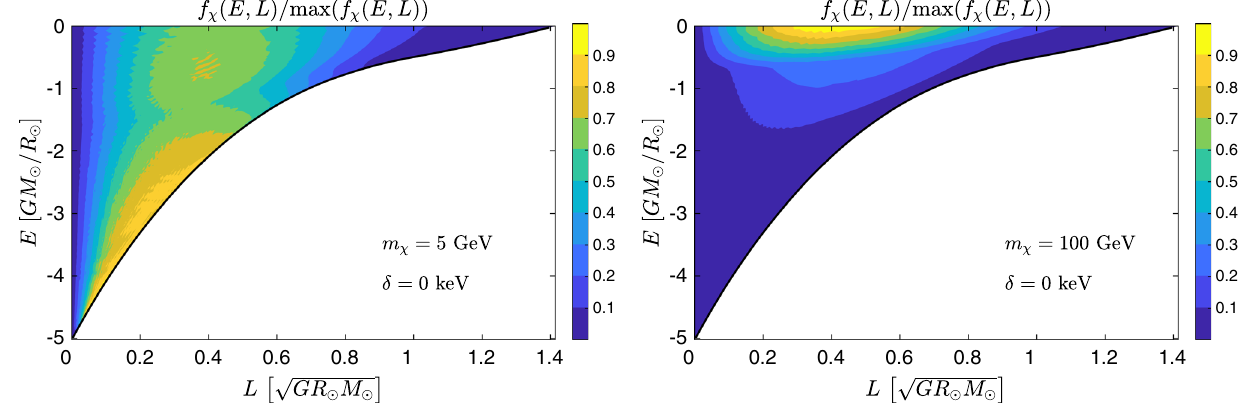
Fig. 1 The density of dark matter capture in the E - L plane normalized by the largest value of the distribution. Elastic scattering is assumed. Left panel: m χ = 5 GeV. Right panel: m χ = 100 GeV